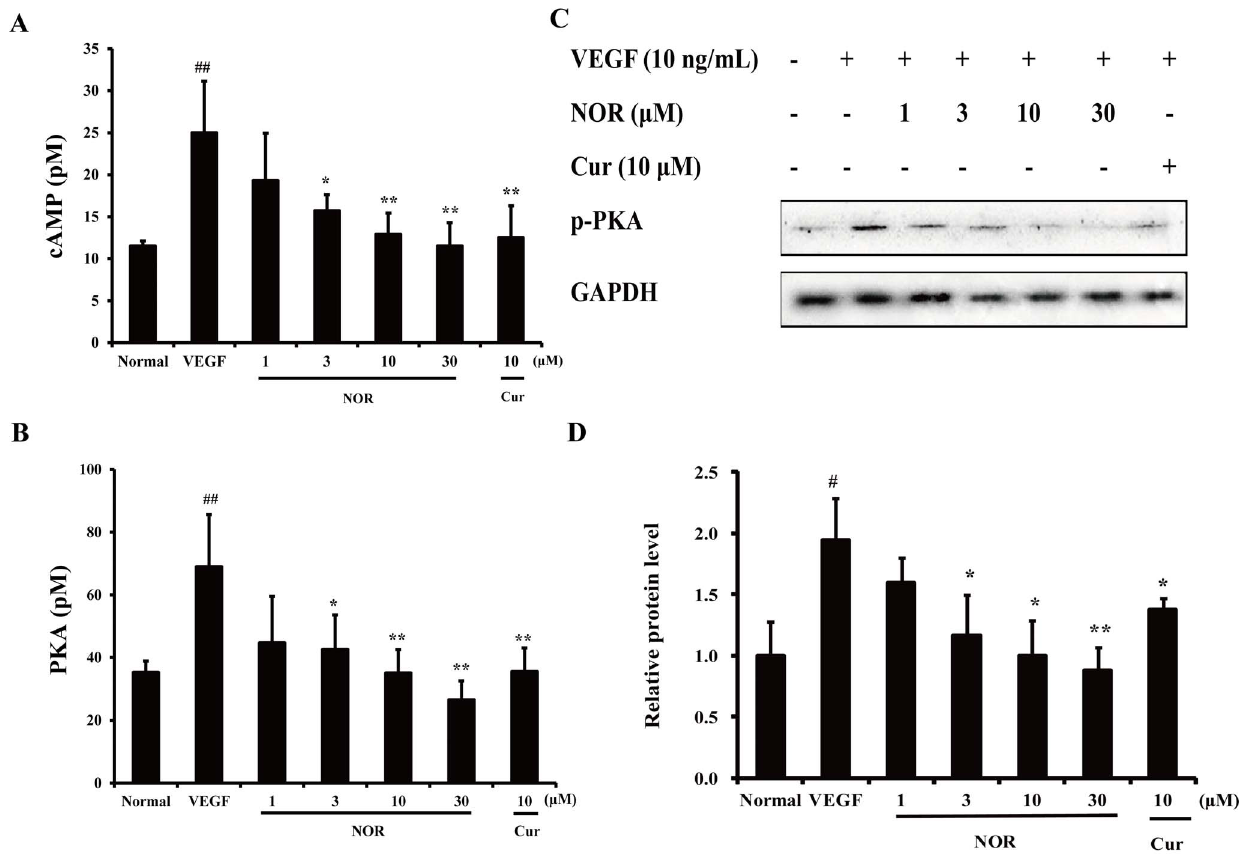
Figure 4. The effect of NOR on the VEGF-induced intracytoplasmic cAMP level and PKA activation in HUVECs. ( A ). Effect of NOR on VEGF-induced intracytoplasmic cAMP level. Cells were treated with NOR and VEGF (10 ng/ml) for 24 h. ( B ). Effect of NOR on VEGF-induced PKA catalytic activity. Cells were treated with NOR and VEGF (10 ng/ml) for 24 h. ( C ). Effect of NOR on VEGF-induced PKA phosphorylation. Cells were pretreated with NOR for 24 h, stimulated by VEGF for 20 min, and then harvested for western blot analysis. ( D ). Quantification of PKA phosphorylation. The data are expressed as mean 6 SD of three independent experiments. # P , 0.05, ## P , 0.01 vs . normal group; * P , 0.05, ** P , 0.01 vs. VEGF group. NOR, norisoboldine; Cur,